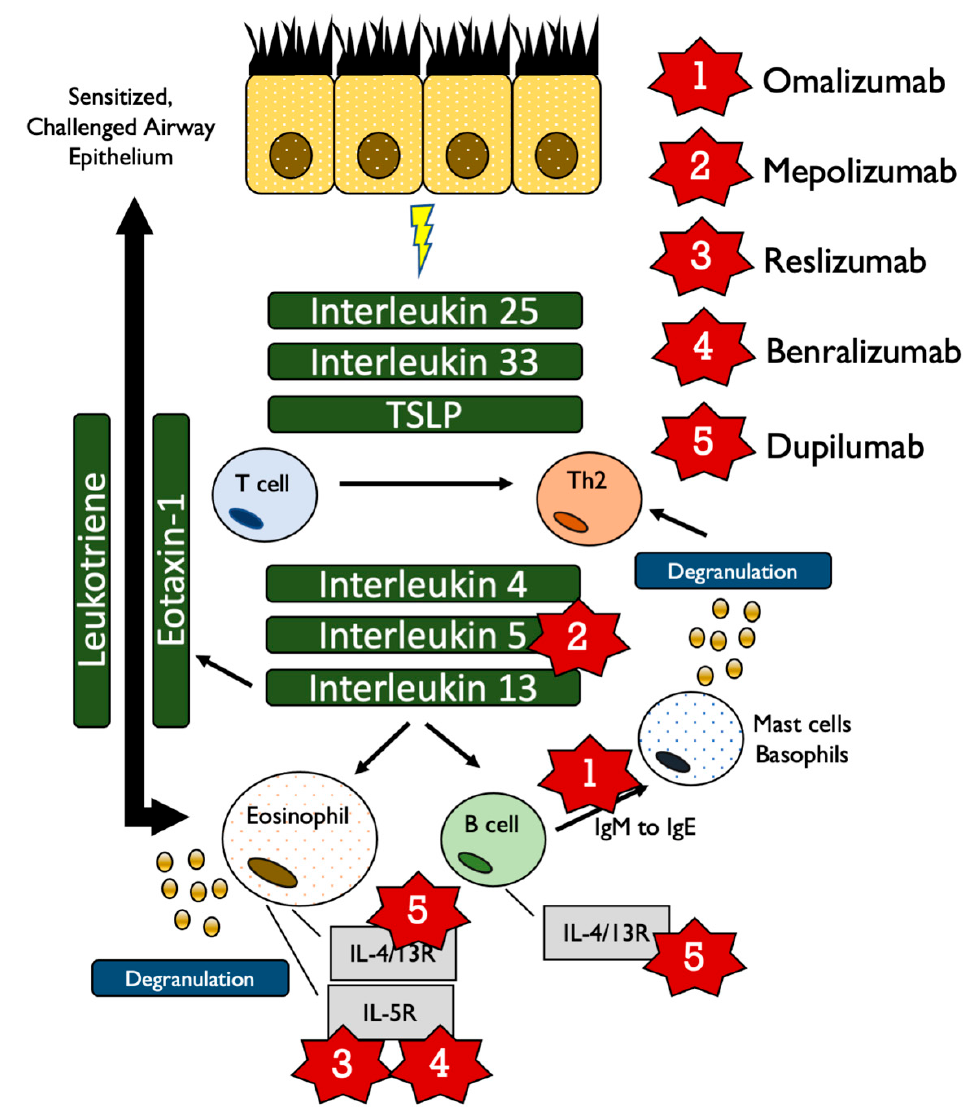
Figure 2. The specific targets of the current generation of biologics within the inflammatory cycle